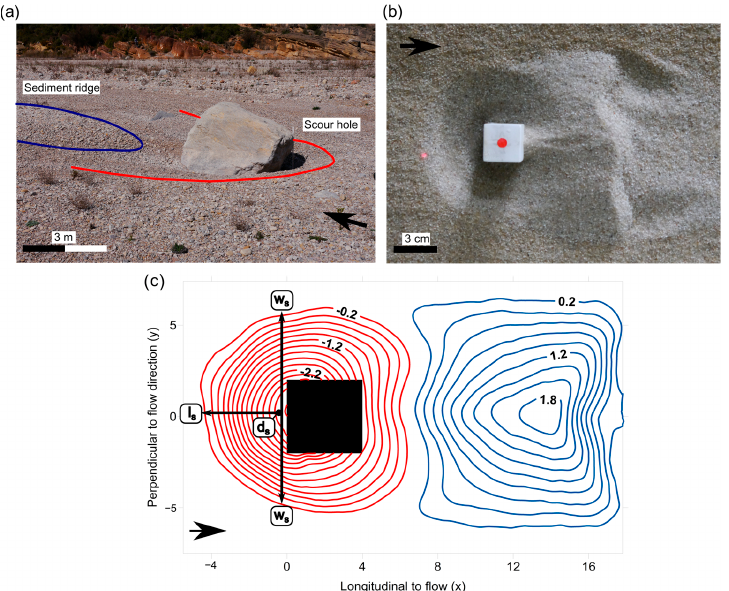
Figure 1. ( a ) Local scour hole at a boulder in ephemeral Rambla de la Viuda, NE Spain, 2019. ( b ) Local scour hole at a cube generated in a flume. ( c ) Plan view of a local scour hole at a cuboid obstacle at laboratory scale (cm) indicating local scour hole (red isolines) and sediment ridge (blue isolines). Arrows indicate direction of flow. Reprinted from Schlömer et al. [29].